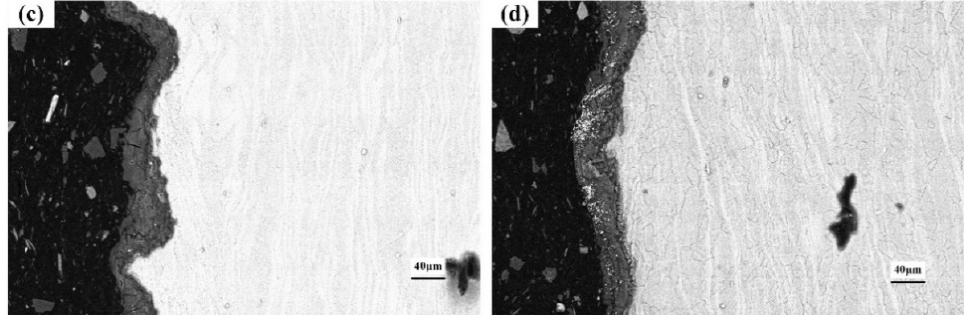
Figure 12. Cross-section morphology after corrosion in 0.2 mol/L Cl − solution: ( a ) 4 h; ( b ) 8 h; ( c ) 18 h; ( d ) 36 h.